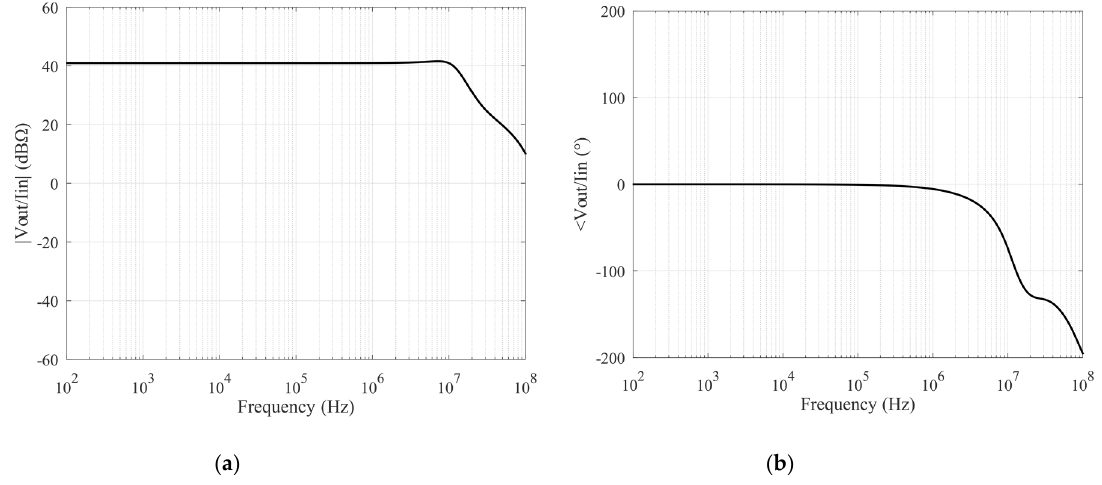
Figure 7. Transimpedance characteristics: magnitude ( a ) and phase ( b ).